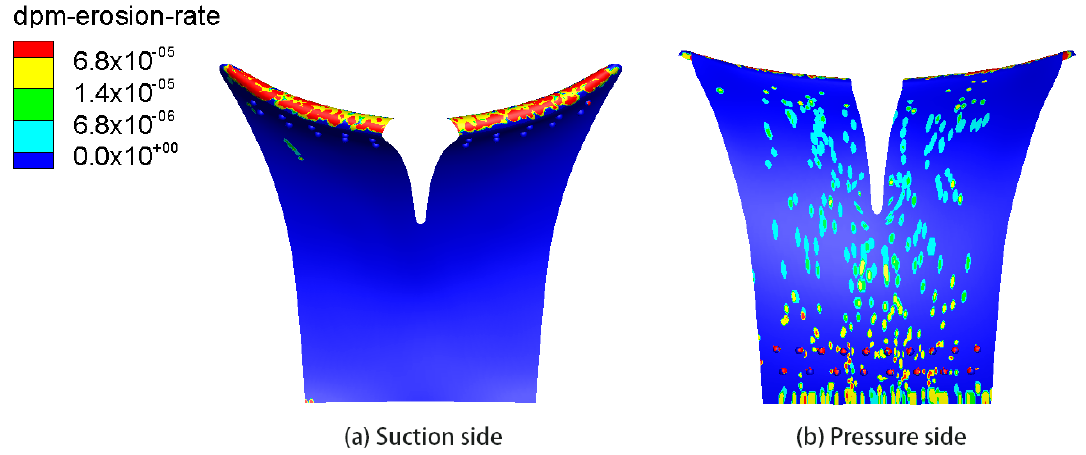
Figure 21. Silt erosion on blade surface with bionic convex domes (units: μ m/s, silt concentration: 3.5 kg/m 3 ).